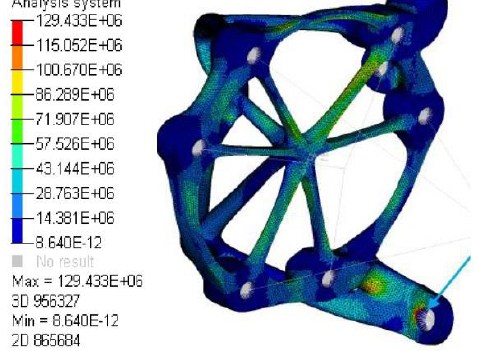
Figure 7. Results of FEM simulation analysis.